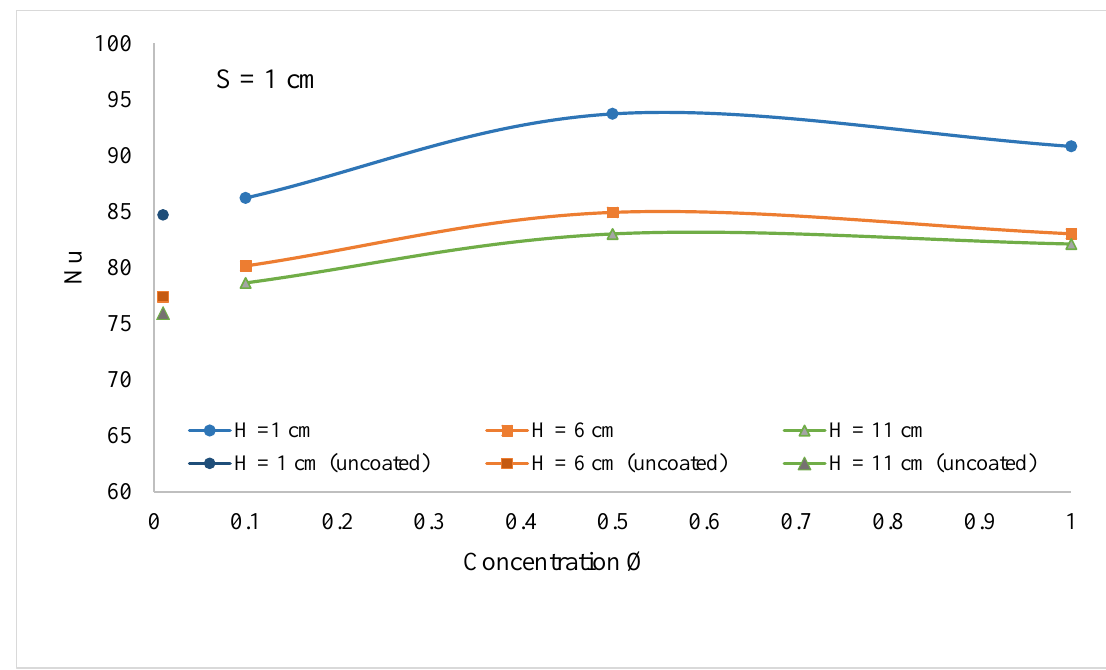
Figure 17. Interaction of nozzle-plate distance and phase angle levels at optimum levels of other factors at nozzle-nozzle spacing = 1 cm. Table 5. Improvement ratio of TiO 2 nanocoating surface plate.